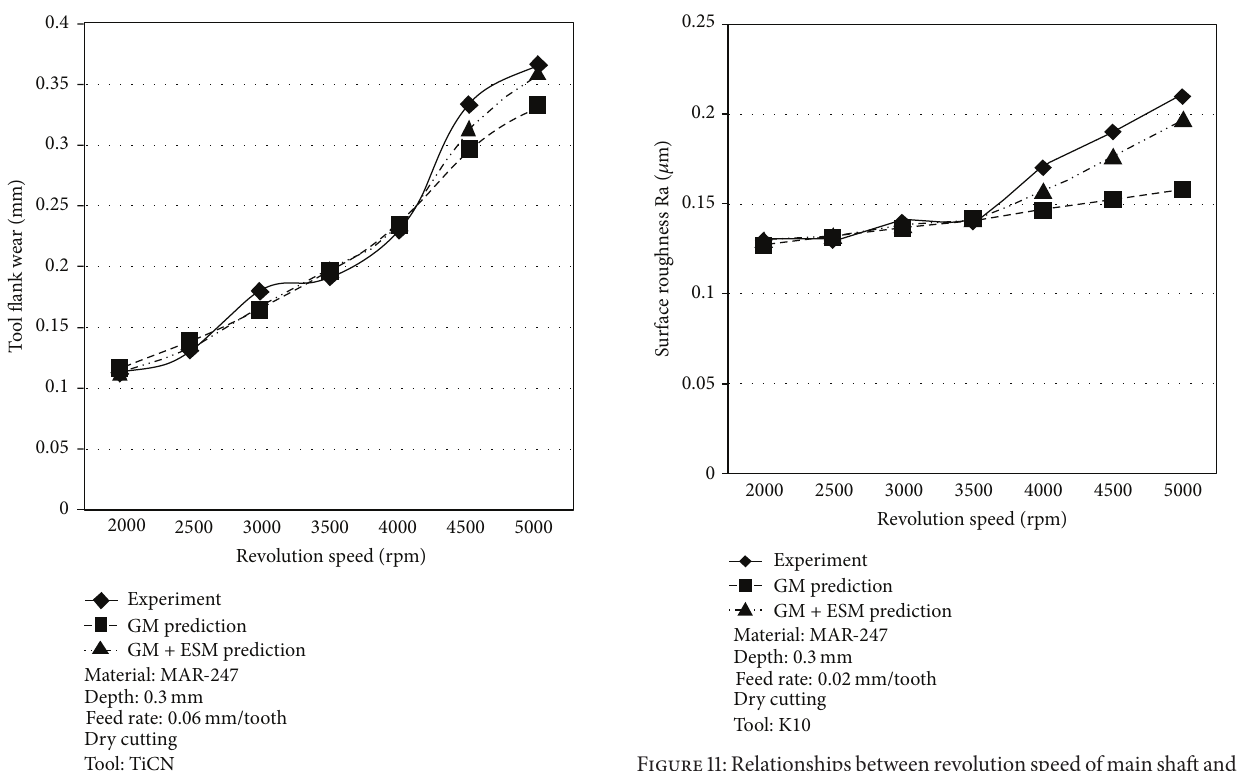
Figure10:Relationshipsbetweenrevolutionspeedofmainshaftand tool wear prediction.